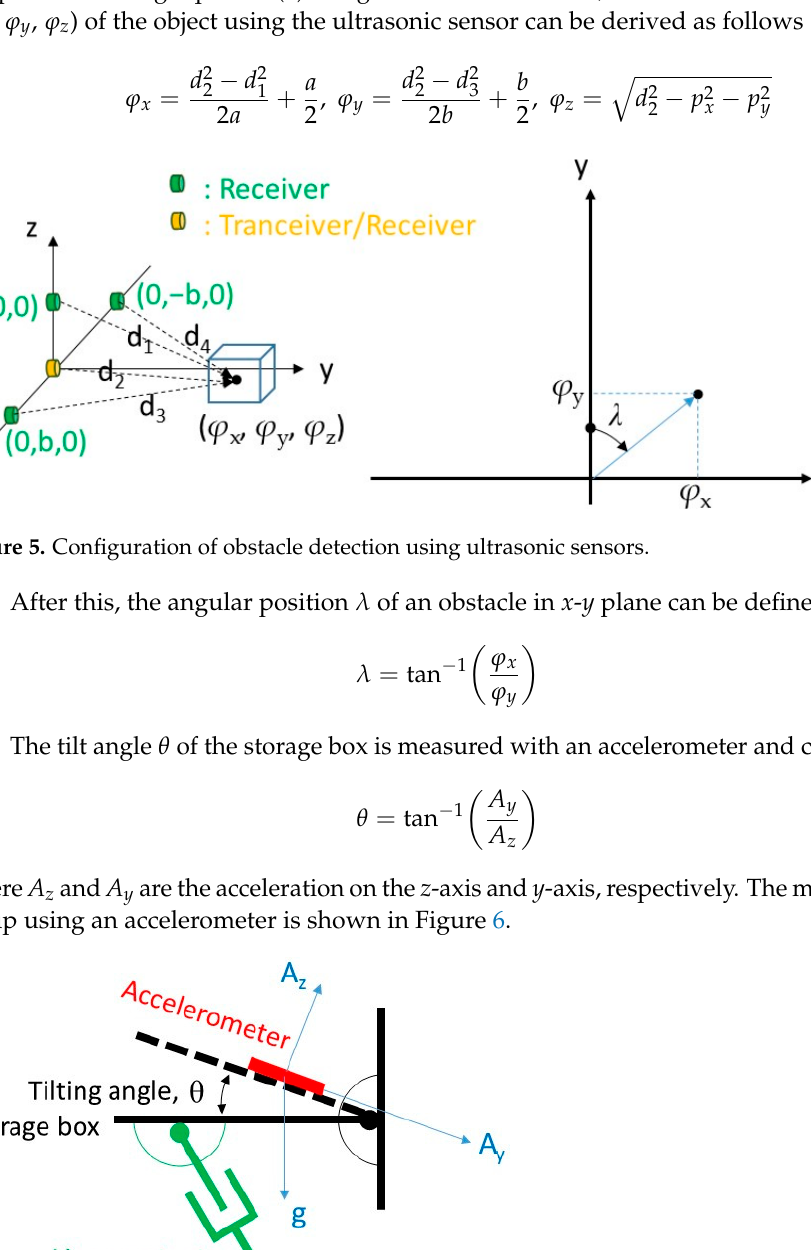
Figure 6. Geometry configuration for detecting the tilting angle, θ , of a storage box.